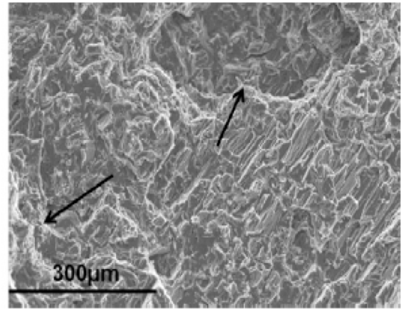
Figure 8. Fractographic analyses of AZ91D alloy sample continuously cathodically charged and simultaneously tested in modified simulated body fluid (m-SBF). Reproduced with permission from [83], Elsevier, 2012.